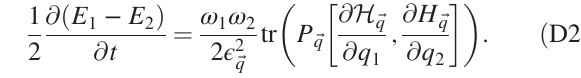
eigenstates of the instantaneous Hamiltonian.